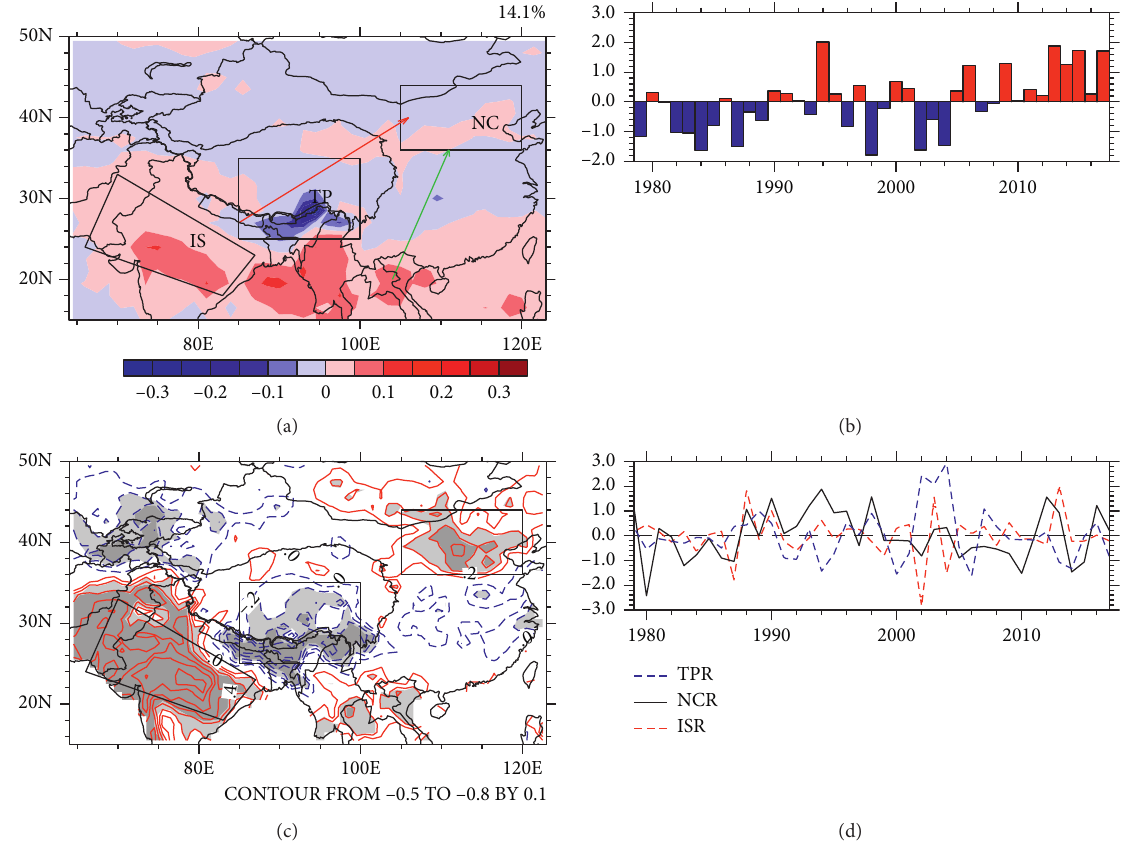
Figure 1: (a) Spatial pattern of the first EOF analysis applied to July-August (JA) APHRODITE rainfall from 1951 to 2007. (b) Principal component corresponding to spatial pattern in (a). (c) Geographical distribution map of the correlation coefficients between JA GPCC rainfall from 1940 to 2013 and the India Subcontinent Rainfall (ISR), dark (light) shadings indicate values exceeding 99% (90%) confidence levels through student’s t test. (d) The time series of the ISR (red dashed line), rainfall over North China (NCR) (blue dashed line) and southeastern Tibetan Plateau Rainfall (TPR) (black solid